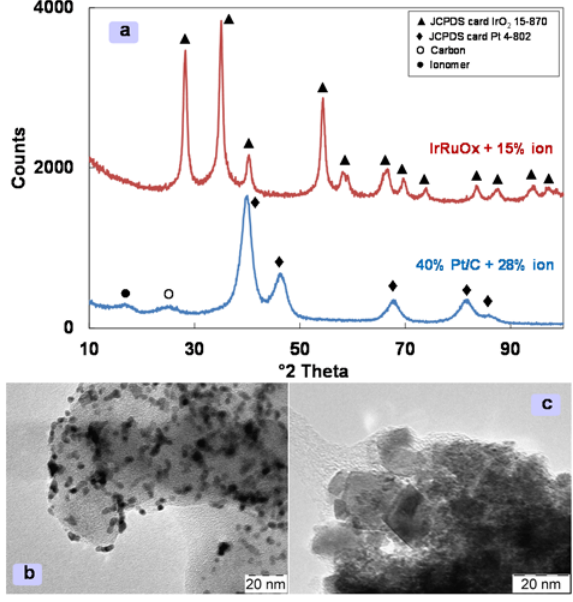
Figure 1. X-ray diffraction of IrRuOx +15% ionomer and 40% Pt/C + 28% ion ( a ); TEM image of 40% Pt/C + 28% ion ( b ); TEM image of IrRuOx +15% ion ( c ).